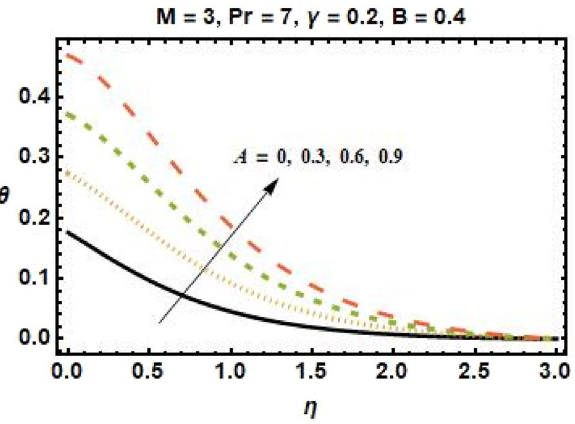
Figure 4. Effects of space-dependent parameter on the temperature profile for A > 0 .